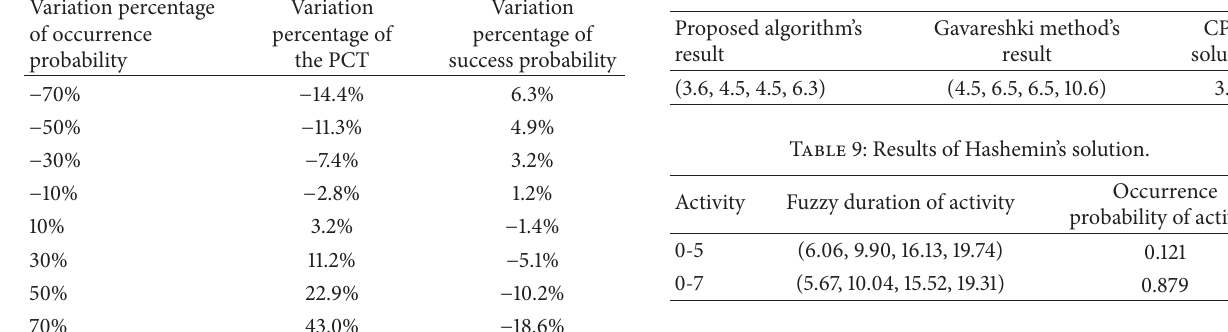
Table 7: Results of sensitivity analysis. Table 8: Proposed algorithm’s results, Gavareshki method’s results, and CPM solution.